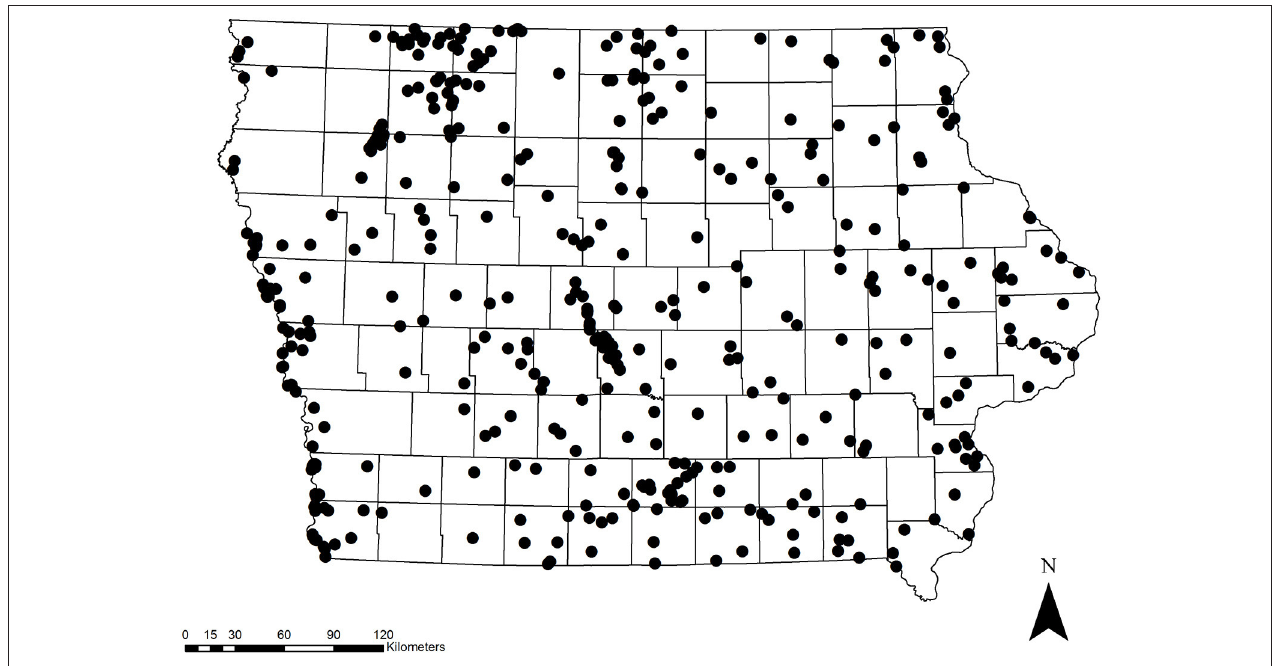
FIGURE 1 | Location of the 417 properties that were surveyed for monarchs in Iowa,